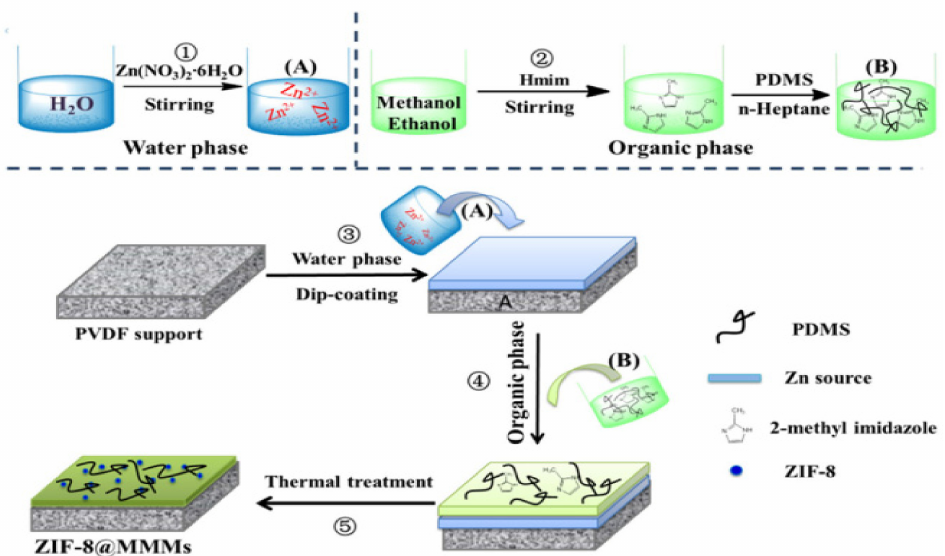
Figure 7. A novel preparation procedure. Preparation procedure of ZIF-8@MMMs membranes. ( A ) (in water phase) ( B ) (in organic phase) [42]—(Reprinted from Journal of Membrane Science, vol. 573, H. Mao, H. Zhen, A. Ahmad, A. Zhang and Z. Zhao, “In situ fabrication of MOF nanoparticles in PDMS membrane via interfacial synthesis for enhanced ethanol permselective pervaporation”, pp. 344–358, Copyright (2021), with permission from